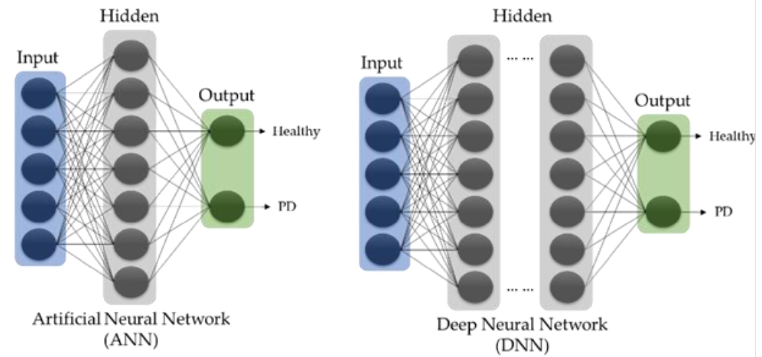
Figure 1. Basic architecture of ANN and DNN